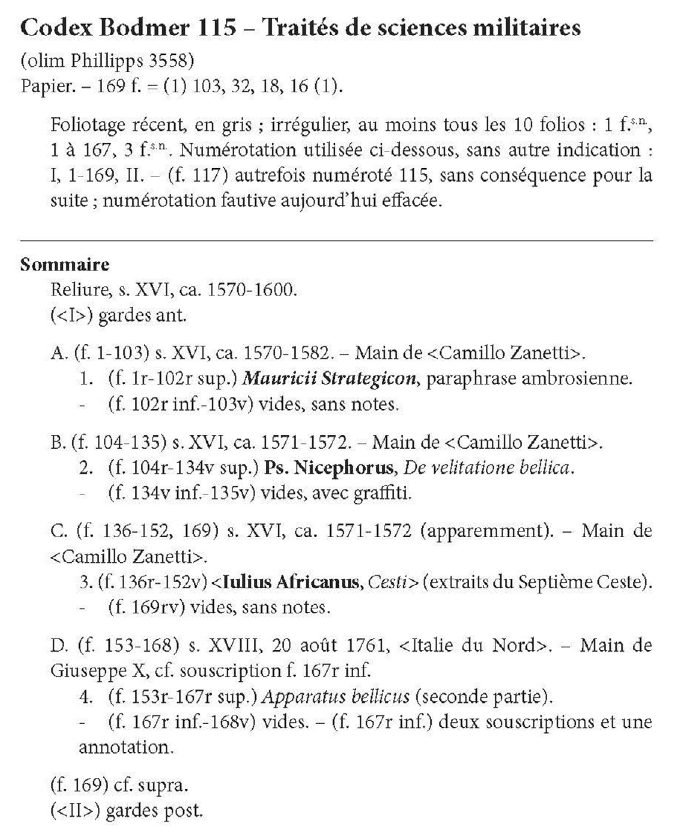
Figure 2. Summary Description of the Codex Bodmer 115, reproduced with the kind permission of the publisher. The Codex Bodmer 115 contains four discrete production units: the first three (A–C) are all the work of the same scribe, Camillo Zanetti, and their time of production can be situated at different points in the second half of the 16 th century with reasonable certitude. The last production unit (D) is dated to 1761. From a